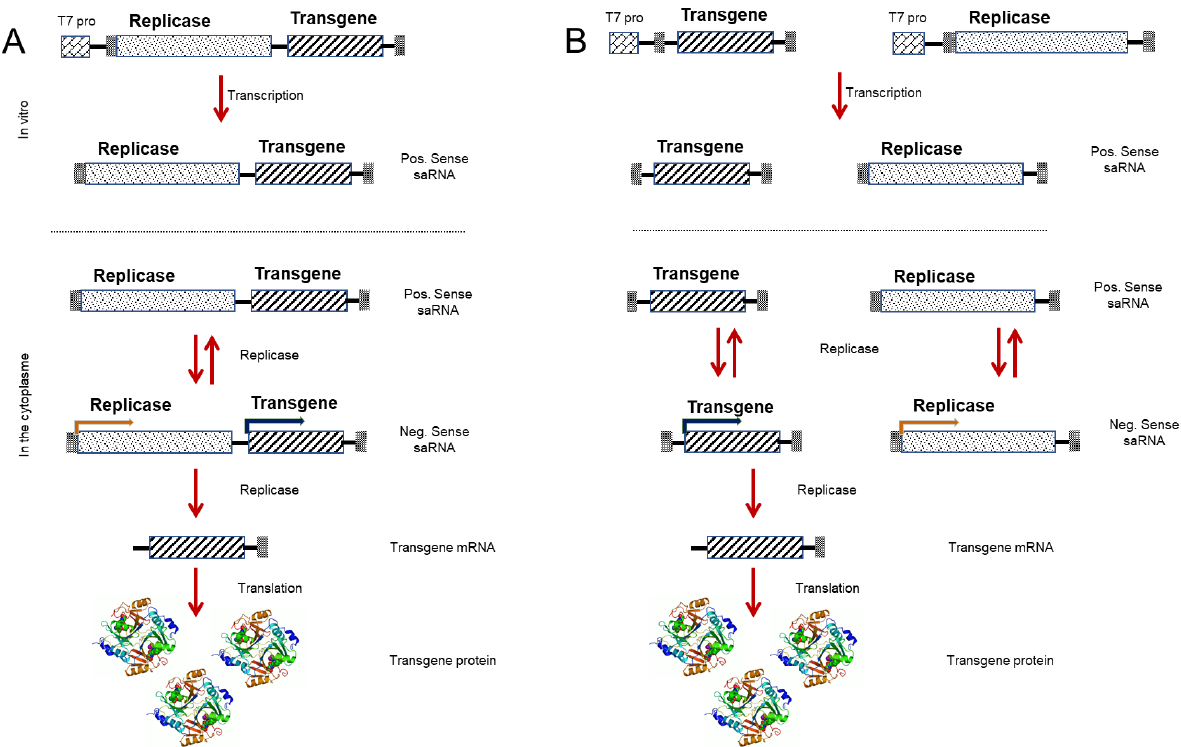
Figure 4. RNA based vaccines. Plasmid DNA carrying replicase genes (for the replication of RNA) and/or the transgene (which encodes the gene of interest) can be transcribed in vitro using a T7 promoter transcription system to generate replicons or positive sense RNAs (Pos sense RNA). ( A ) The replicon RNA encodes the replicase machinery and the transgene are delivered into the cell using lipofectamine or similar synthetic formulations. Within the cytoplasm, the replicon RNA self-replicates and produce transgene mRNA from the subgenomic promoter, which is translated to protein. ( B ) The replicon RNA encoding the replicase machinery and the transgene are delivered “in trans ”. Within the cytoplasm, the replicon RNA self-replicates and produces transgene mRNA using a subgenomic promoter, which is subsequently translated to protein.